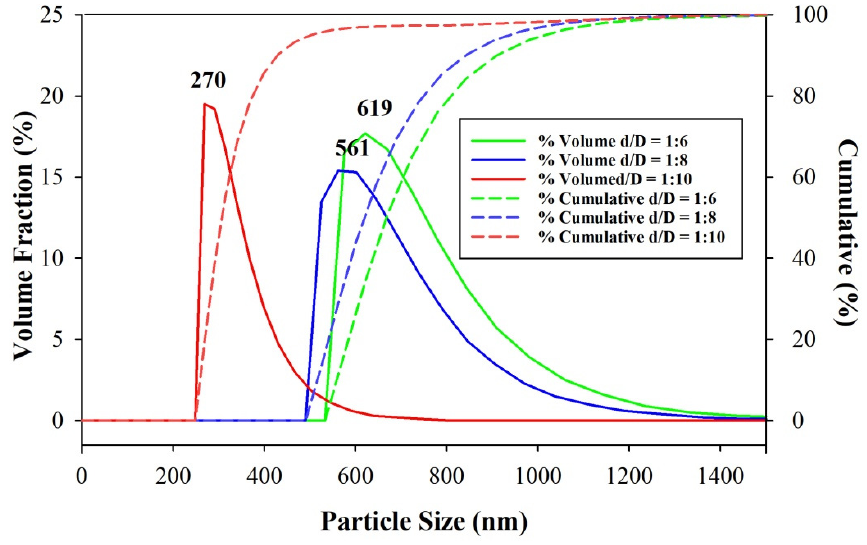
Figure 6. Effect of d/D ratio on the particle size distribution.